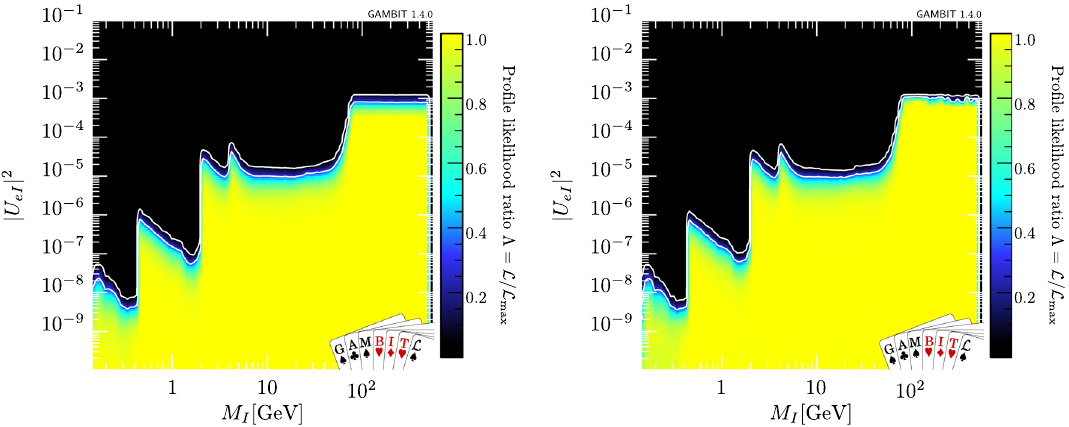
Fig. 1 Profile likelihood in M I vs U 2 plane for normal (left) and inverted hierarchy (right). Tables with the 90% and 95% CLs for both hierarchies eI can be found in Zenodo [186]